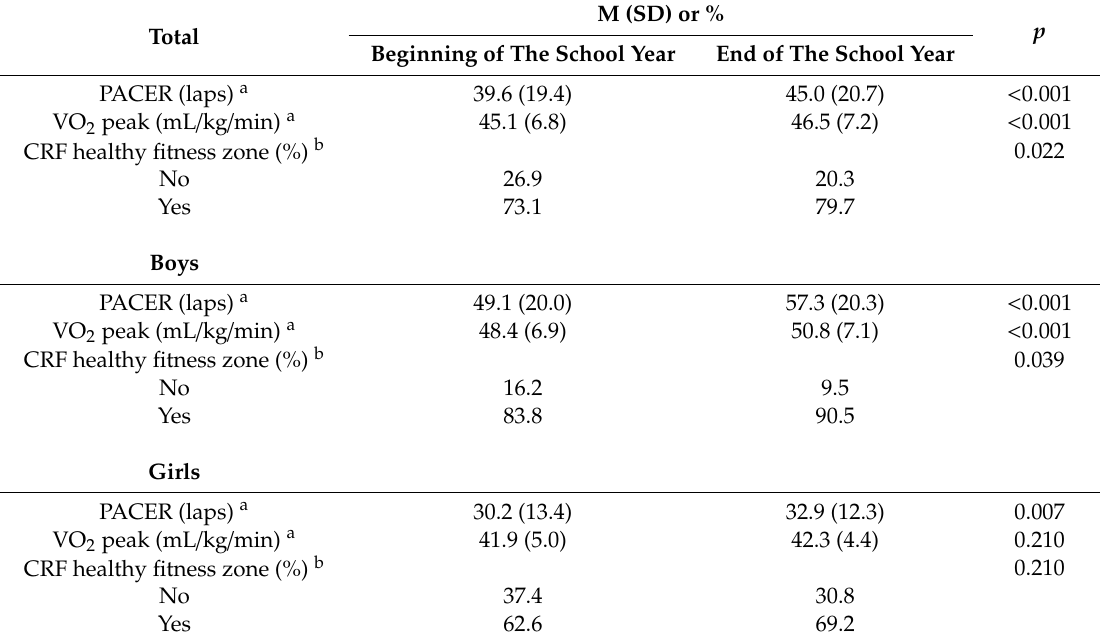
Table 2. Aerobic capacity and healthy fitness zone at the beginning and at the end of the school